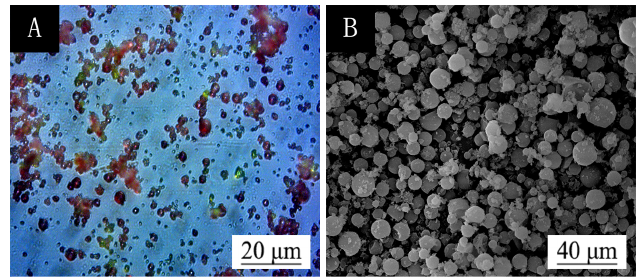
Figure 3. Micrograph ( A ) and SEM ( B ) of the color-changing powder.